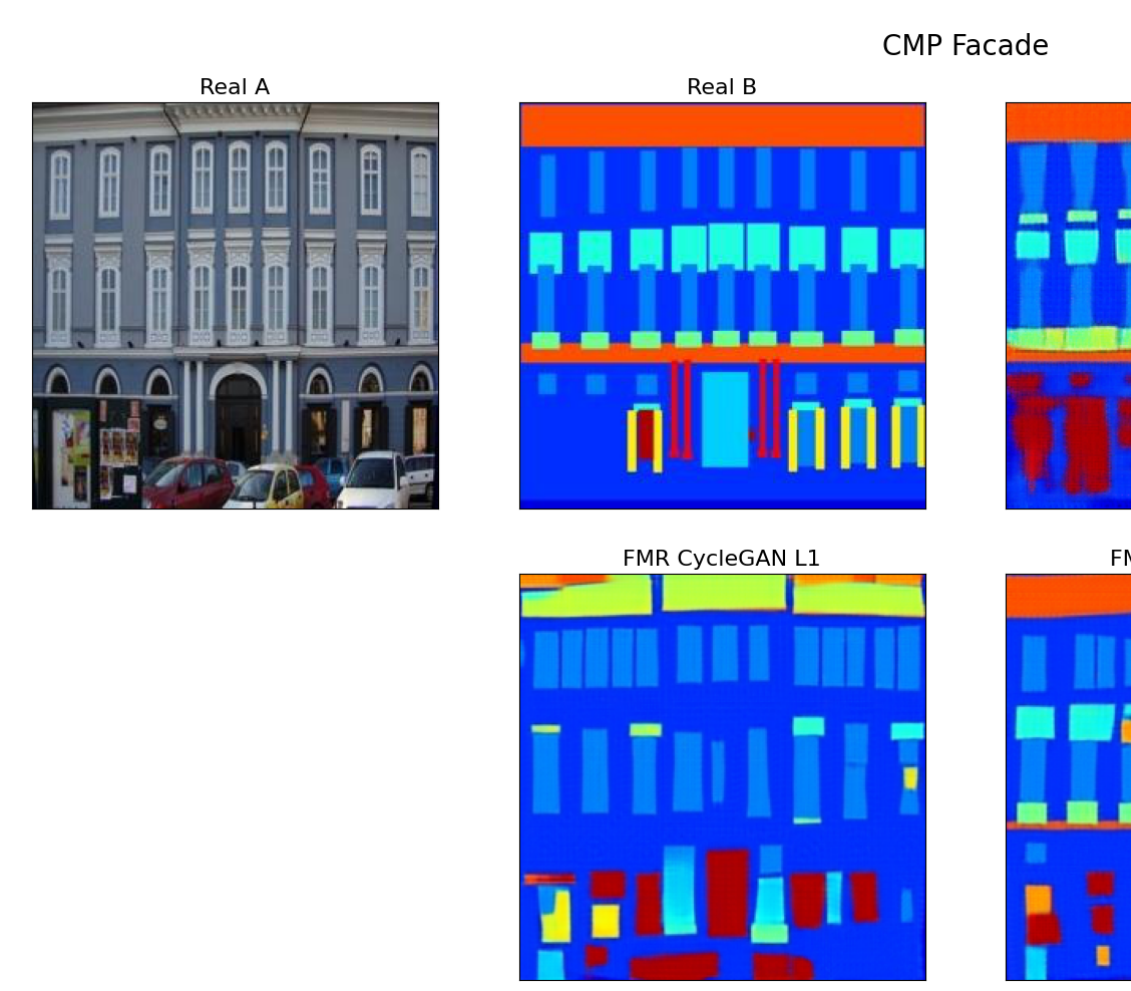
Figure 4. Visual comparison on the first example of paired images from the CMP Facade photo2labels task (denoted as “Real A”, belonging to the source or “left” domain, and “Real B”, belonging to the target or “right” domain). The Proposed FMR CycleGAN with various ground distances (L1 corresponding to (8), KL corresponding to (10), and LE corresponding to (12)) was compared against the baseline CycleGAN and pix2pix